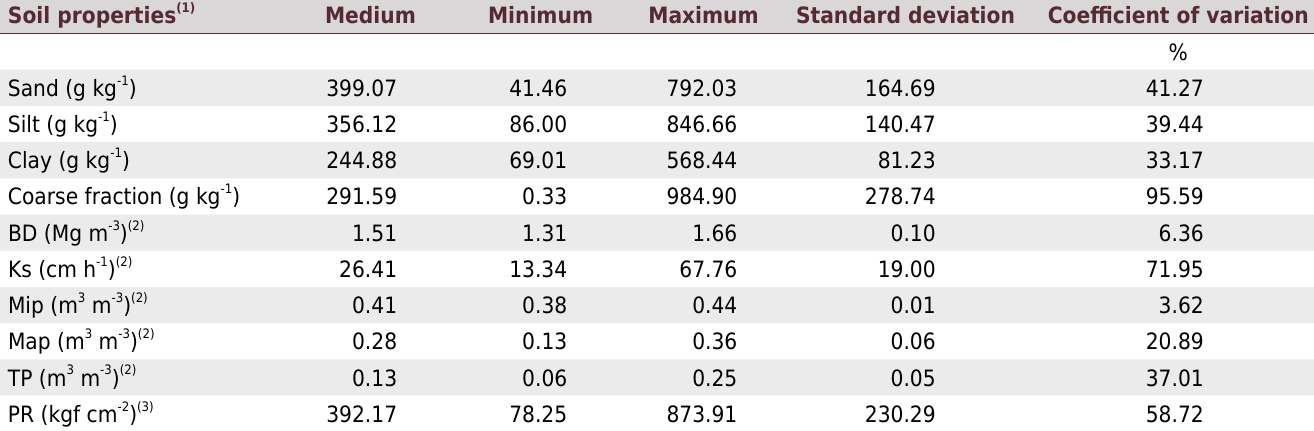
Table 6. Classification of urban soils according to the WRB (IUSS Working Group WRB, 2015) considering only morphological and physical qualifiers